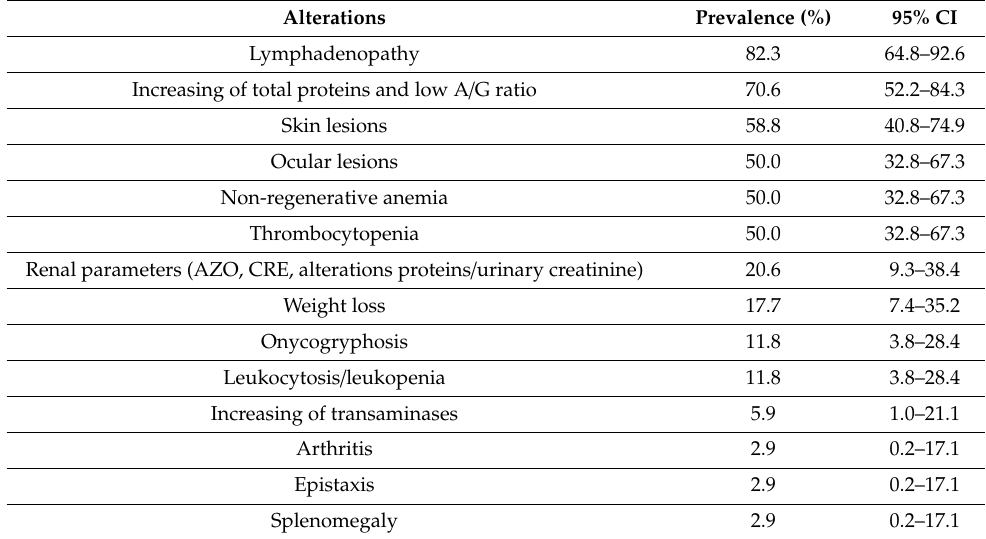
Table 1. Frequency of clinical and clinicopathological alterations detected in chosen dogs.